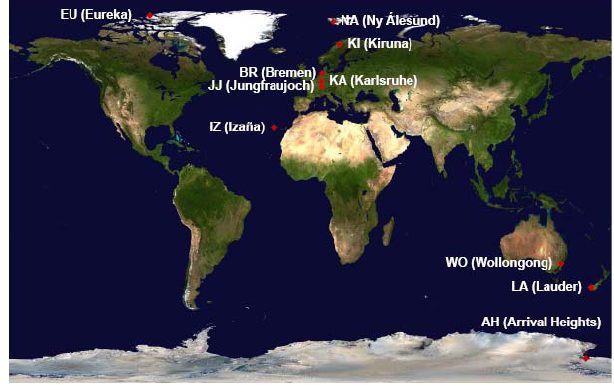
Fig. 1. Global distribution of the ground-based NDACC-FTIR sta- tions contributing to MUSICA.